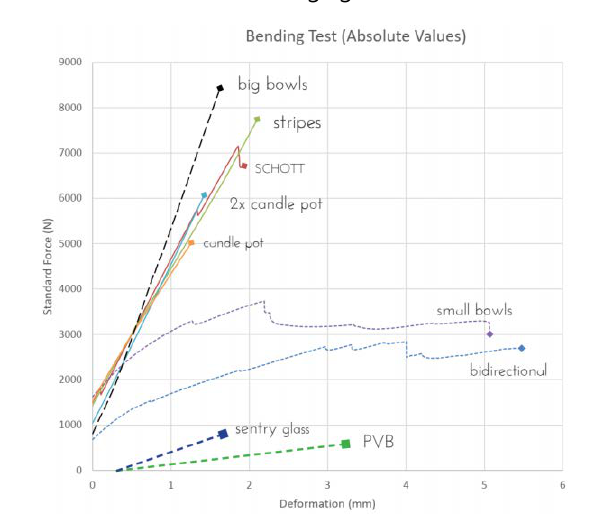
Fig. 2 bending test results for prototype panels.